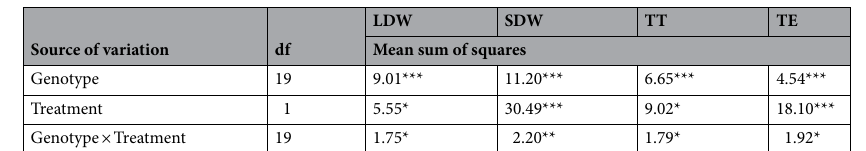
Table 3. ANOVA for physiological and yield related traits in groundnut under lysimeter. *: significant at < 0.05, **: significant at < 0.01, ***: significant at < 0.001 probability level. LDW- Leaf dry weight (g); SDW— Stem dry weight (g); TT—Total transpiration per plant (g); TE—Transpiration efficiency (g/kg).